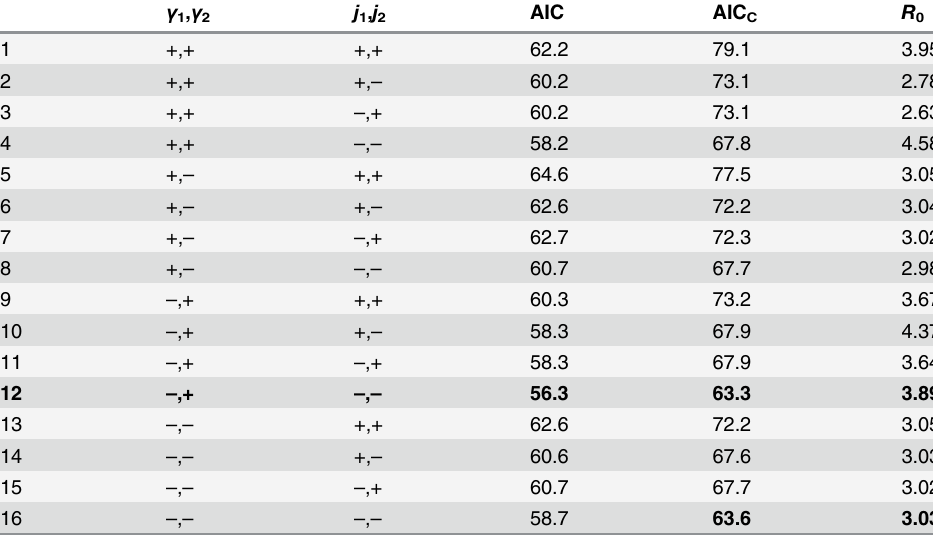
Table 3. Fitting 6 to 10 parameter models to data, with culling terms γ 1 , γ 2 and immigration terms j 1 , j 2 present (+) or absent ( – ); see Eqs (12) and (13). The model in row 12 with the lowest AIC and AIC C is shown in bold; it shows no culling effect for males. AIC C also supports model in row 16 with no culling effect for either males or females. None of the best models show significance of immigration terms. γ γ 1 ,